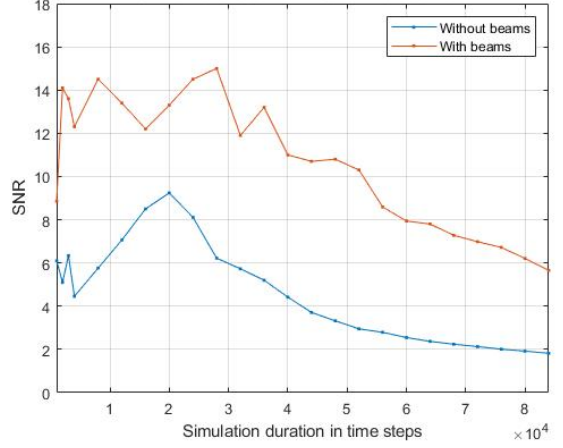
Figure 5. SNRs vs simulation time for when beams are and are not present inside the